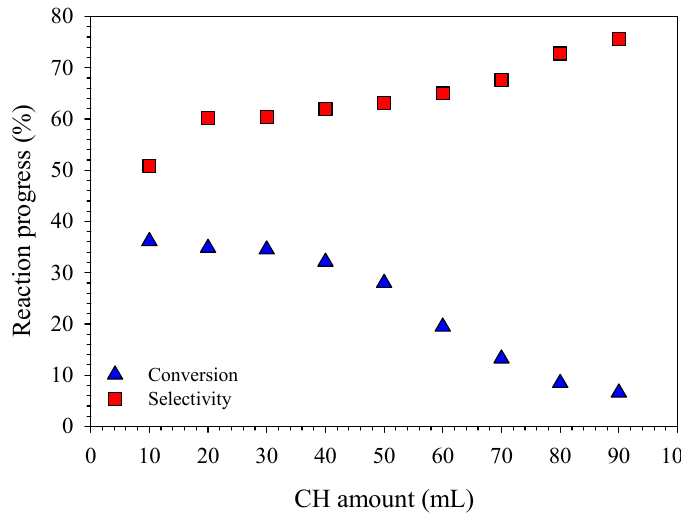
Figure 3. CH-to-COH / RCOR conversion as a function of a CH amount. Conditions: Cat: 0.15 g, pO 2 : Figure 3. CH-to-COH/RCOR conversion as a function of a CH amount. Conditions: Cat: 0.15 g, pO 2 : 570 Torr, duration: 210 min, temp: 80 ◦ C, flow rate: 40 mL / 570 Torr, duration: 210 min, temp: 80 °C, flow rate: 40 mL/min.